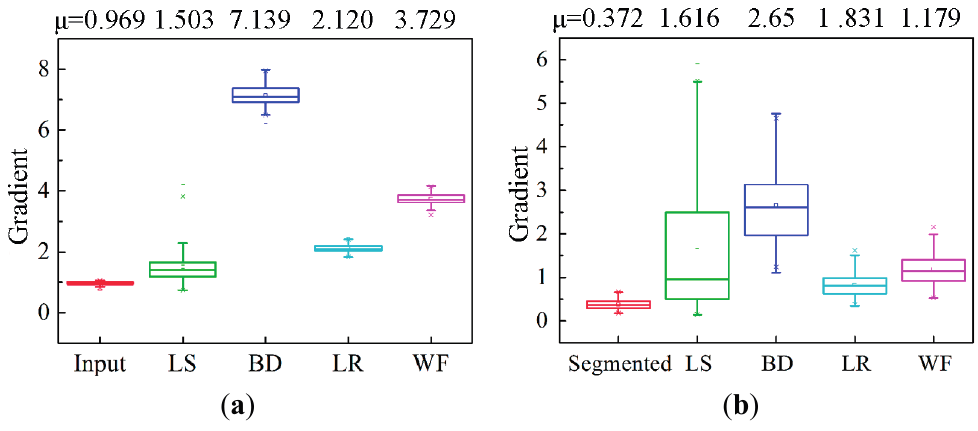
Figure 17. Boxplots of all 110 experimental image gradients: ( a ) gradient of the processed image based on the whole image and ( b ) gradient of the restored result based on partial blurred